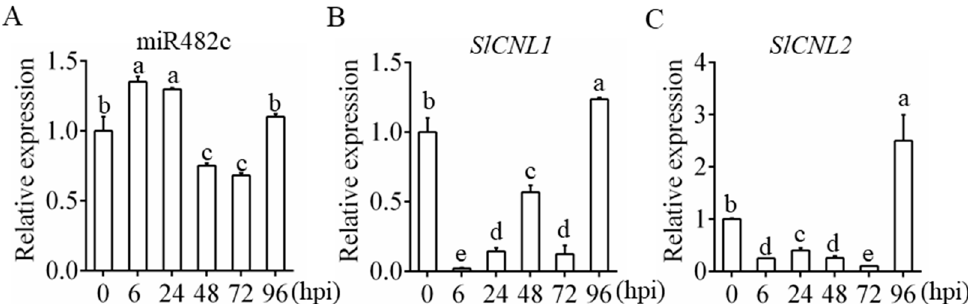
Figure 1. MiR482c and SlCNL expression patterns upon infection. ( A , B , C ) The abundance of miR482c ( A ), SLCNL1 ( B ), and SlCNL2 ( C ) in wild-type (WT) plants upon infection. hpi: hours postinfection. The tomato housekeeping gene actin was selected as the reference gene. standard deviations (SDs) of three replicates are indicated with error bars. The letters above the column indicate a significant difference ( p < 0.05) between the samples.